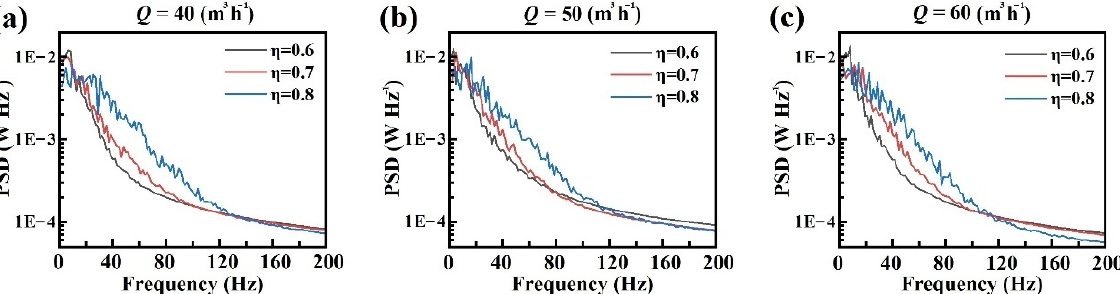
Figure 7. Power spectrum density functions of the meridian section: ( a ) the function curves at flow Q = 40 m 3 h − 1 ; ( b ) the function curves at flow Q = 50 m 3 h − 1 ; ( c ) the function curves at flow Q = 60 m 3 h − 1 .